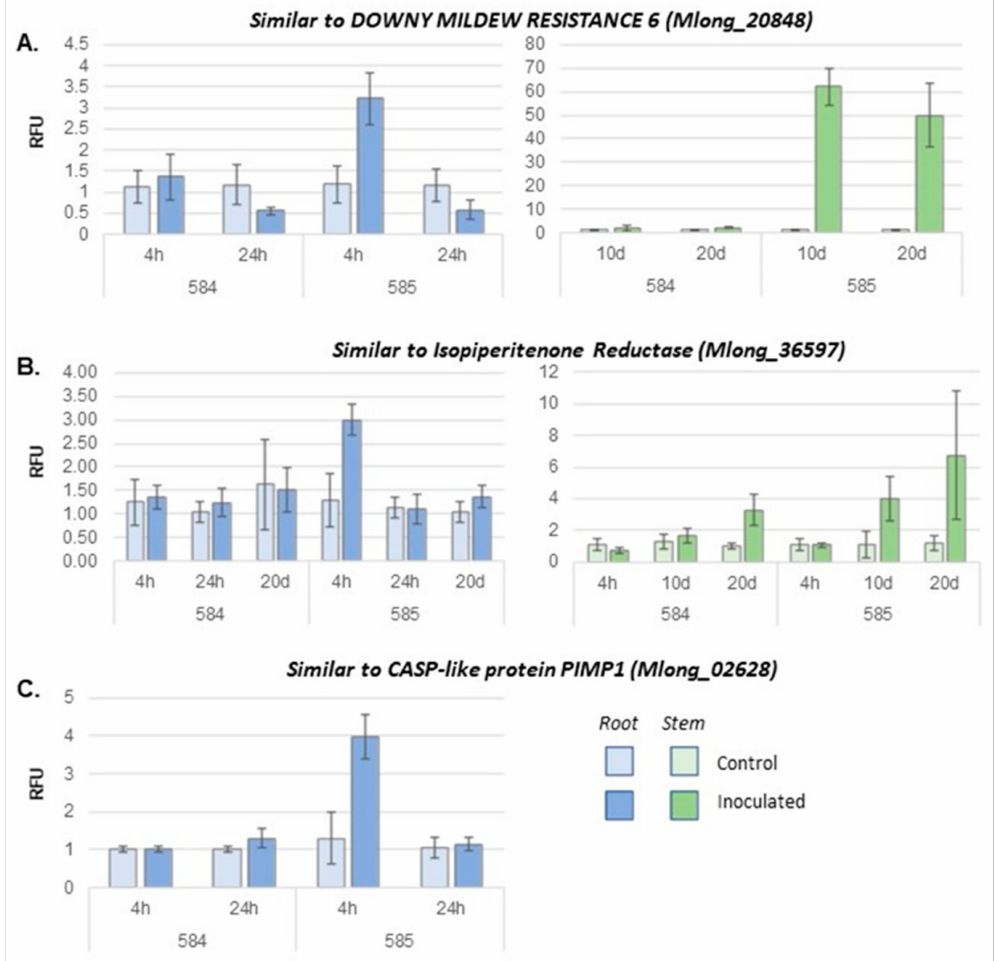
Figure 4. Quantitative RT-PCR (qRT-PCR) results from genes showing upregulation in response to V. dahliae inoculation in CMEN 585 but not in CMEN 584. RFU, relative fluorescence